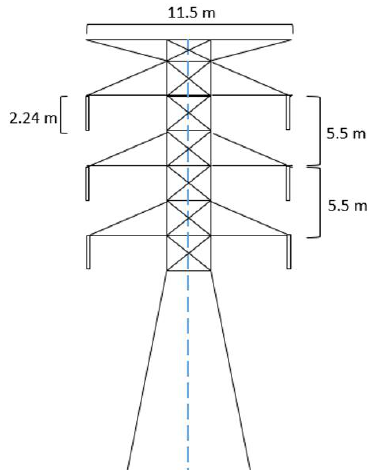
Figure 2. Typical dimensions of a 275 kV transmission line with fiberglass-reinforced polymer (FRP) crossarm.